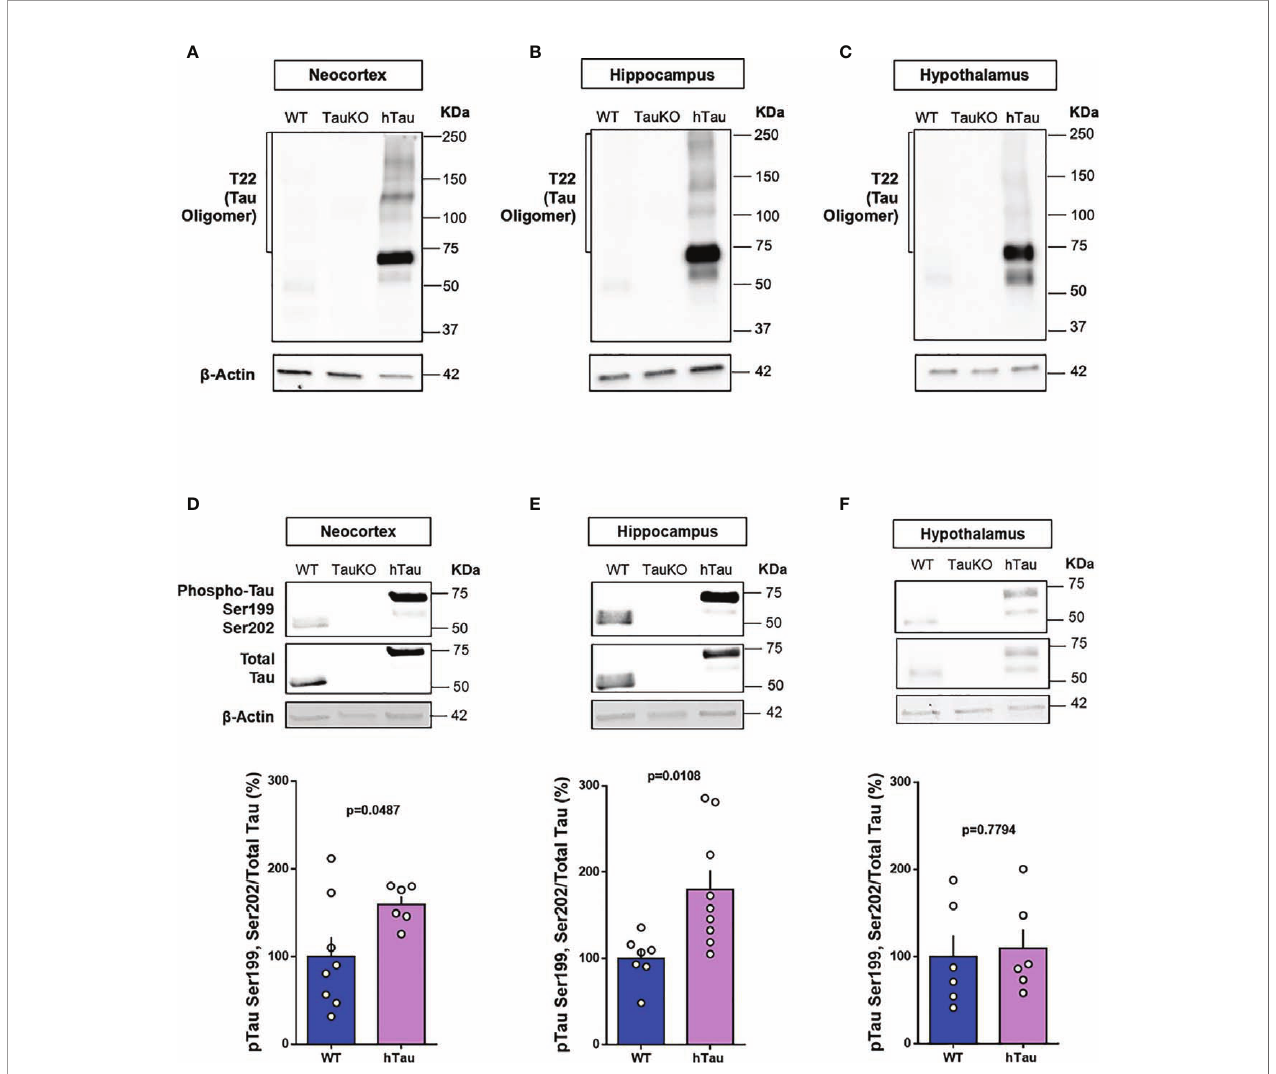
FIGURE 4 | Phospho-tau and tau oligomers are increased in multiple brain regions of hTau mice. Immunoblot analysis of tau oligomers in (A) cortical, (B) hippocampal, and (C) hypothalamic lysates from 20-week-old WT, TauKO, and hTau mice. Immunoblot analysis of pTauSer199Ser202/TotalTau ratio in (D) cortical (n= 8 WT; 6 hTau), (E) hippocampal (n = 7 WT; 9 hTau), and (F) hypothalamic (n = 6 WT; 6 hTau) lysates from 20-week-old WT, TauKO, and hTau